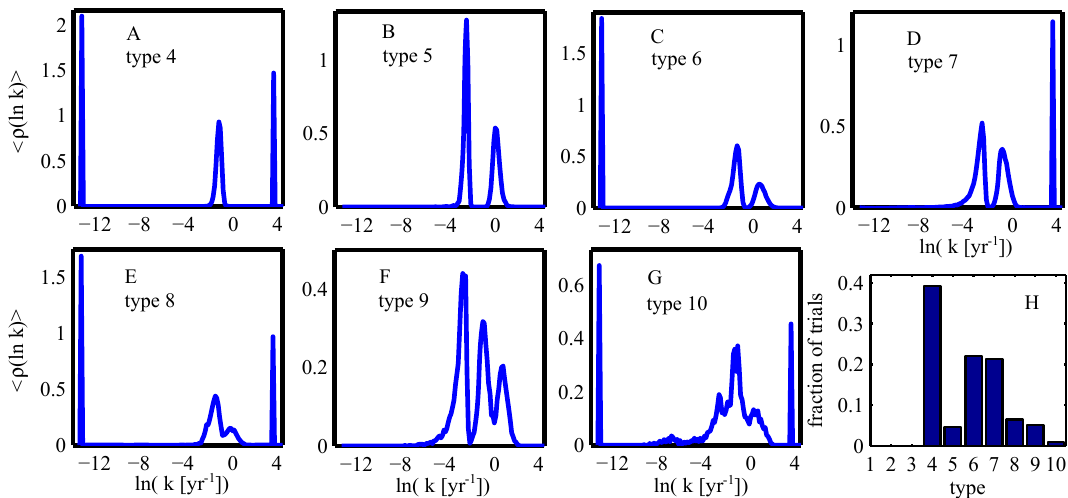
Fig. 2. Distributions ρ( ln k) for 60000 trials of adding random noise to the predicted decay in Fig. 1a. For each trial, ρ( ln k) is estimated using the method discussed in Sect. 3.1. The pools in each solution are then analyzed to determine the model type as described in the text and Table 1, except for model type 9 which is a three active-pool model and type 10 which is any combination of pools not described by models 1–9. (A–G) shows the mean h ρ(k) i for each model type, calculated by summing all of the observed distributions for each type and dividing by the total number of times each type was observed. (H) Fraction of trials that each model type was